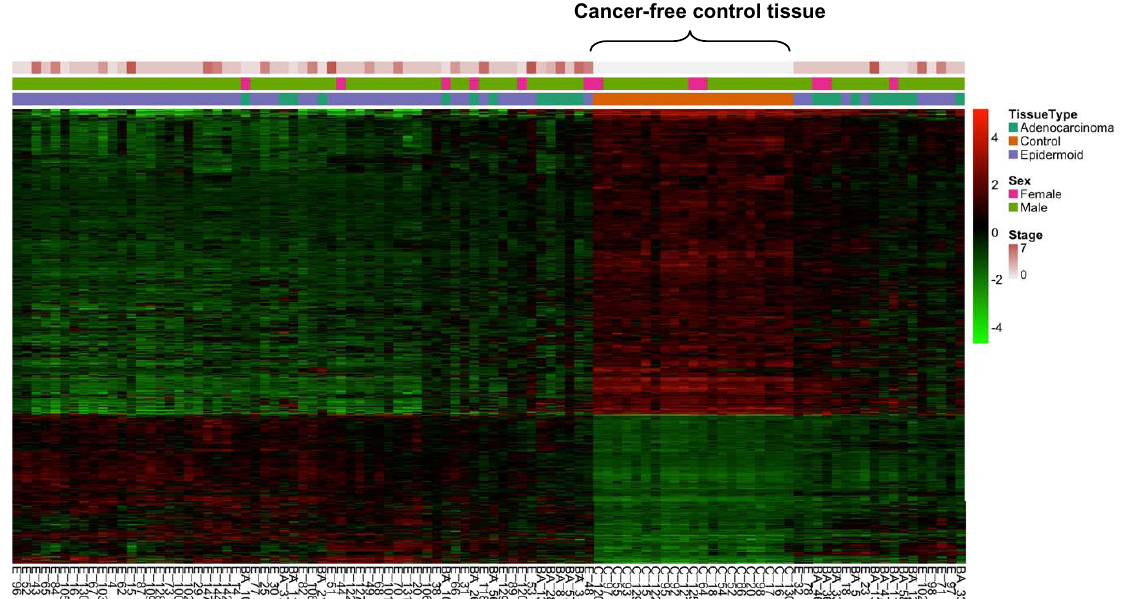
Figure 2. A heatmap demonstrating the differences in gene expression between NSCLC and healthy control tissue. Green marks the down- regulated areas and red the up-regulated markers. Two cancer groups are clearly differentiated from the control group. On the left are mainly squamous cell carcinoma and bronchioalveolar cancers and on the right are adenocarcinomas and squamous cell carcinoma. Sex and stage of cancer do not differentiate in this